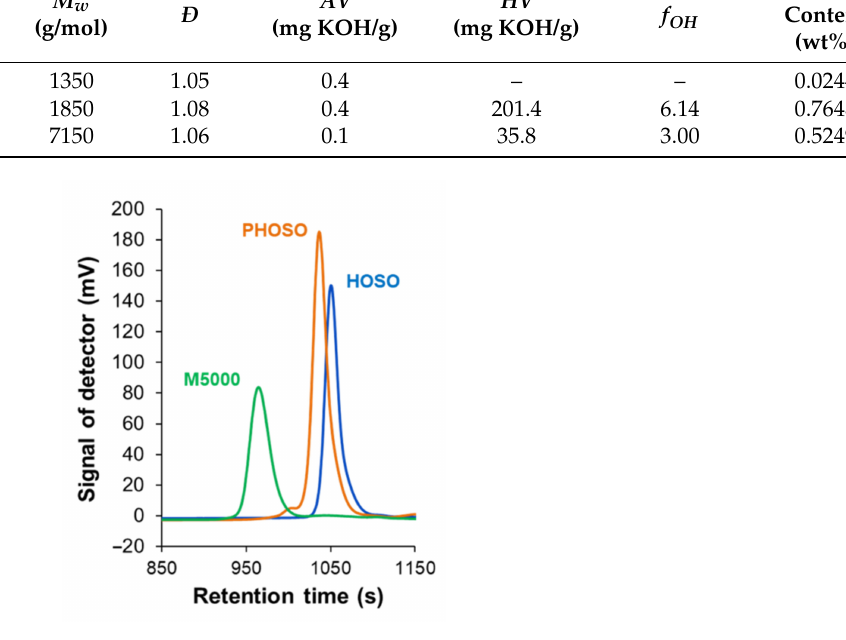
Figure 4. SEC traces of HOSO, PHOSO and